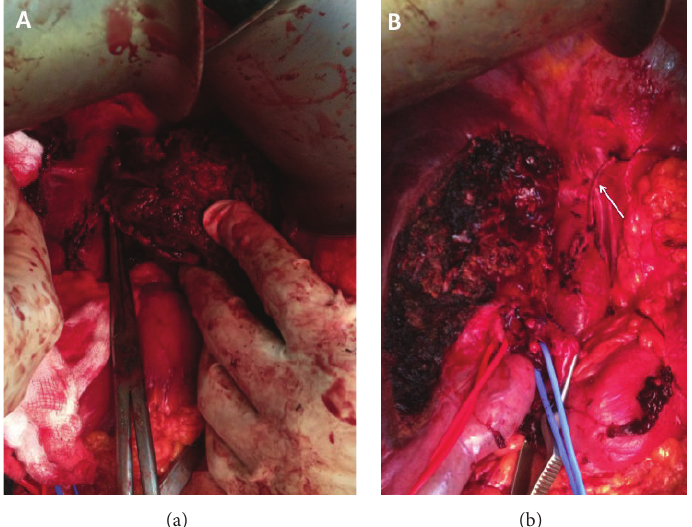
Figure 8: Anterior parenchymal transection allowed the metastasis to be approached from the right side, confirming IVC involvement. The left liver is now completely mobilized except at the point at which the metastatic deposit invades the cava. In (b) the left liver was completely excised and the IVC reconstructed